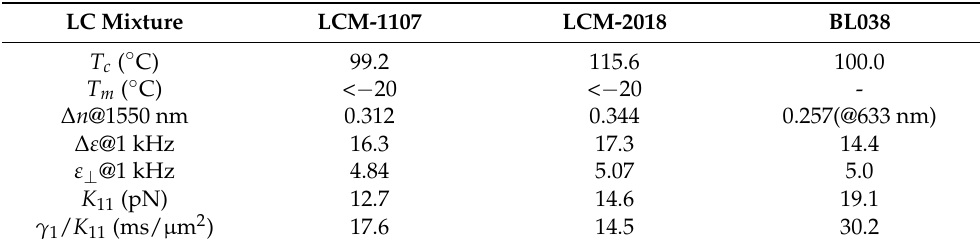
Table 1. Measured physical properties of LCM-1107, LCM-2018, and BL038 at T = 22 ◦ C. LC